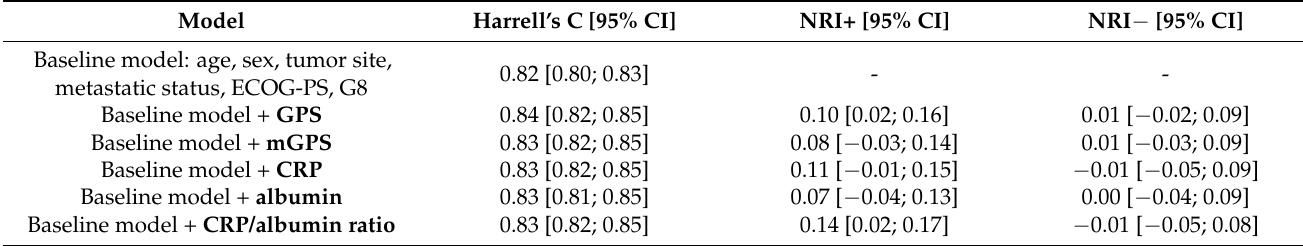
Baseline model: age, sex, tumor